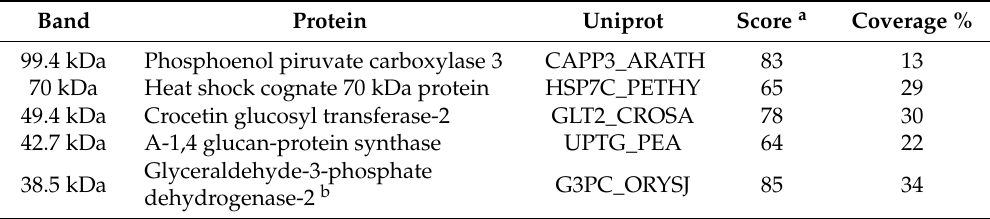
Table 1. Identity of proteins contained in the sample of fresh C. sativus L. stigmas and styles. Band Protein Uniprot Score a Coverage